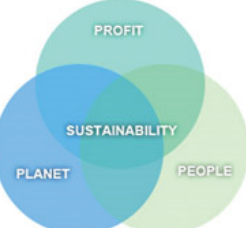
Figure 5. Definition of Sustainability Triple Bottom